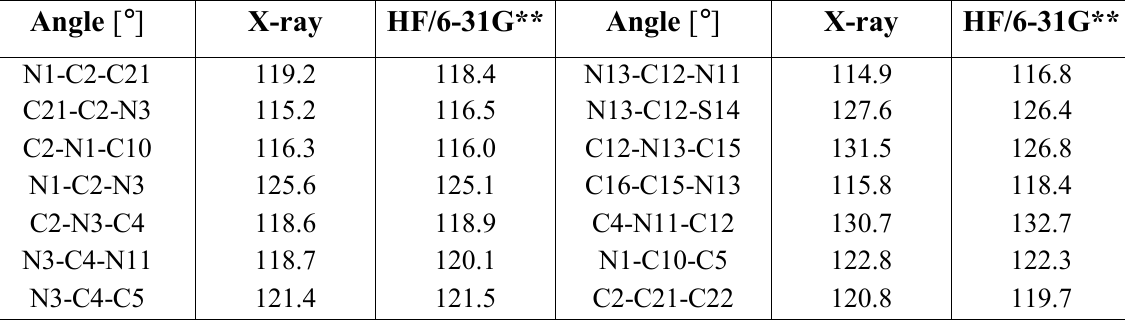
Table 2. The most important bond angles in 7f